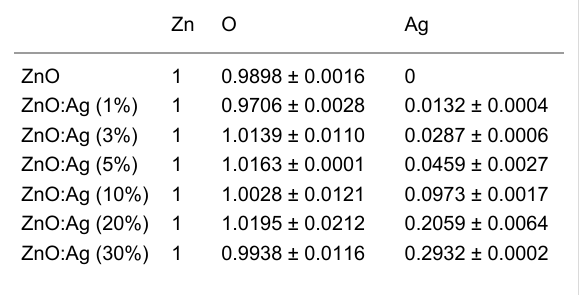
Table 1: RBS analysis of ZnO:Ag nanoparticles indicating the relative quantities of Zn, O and Ag in the prepared